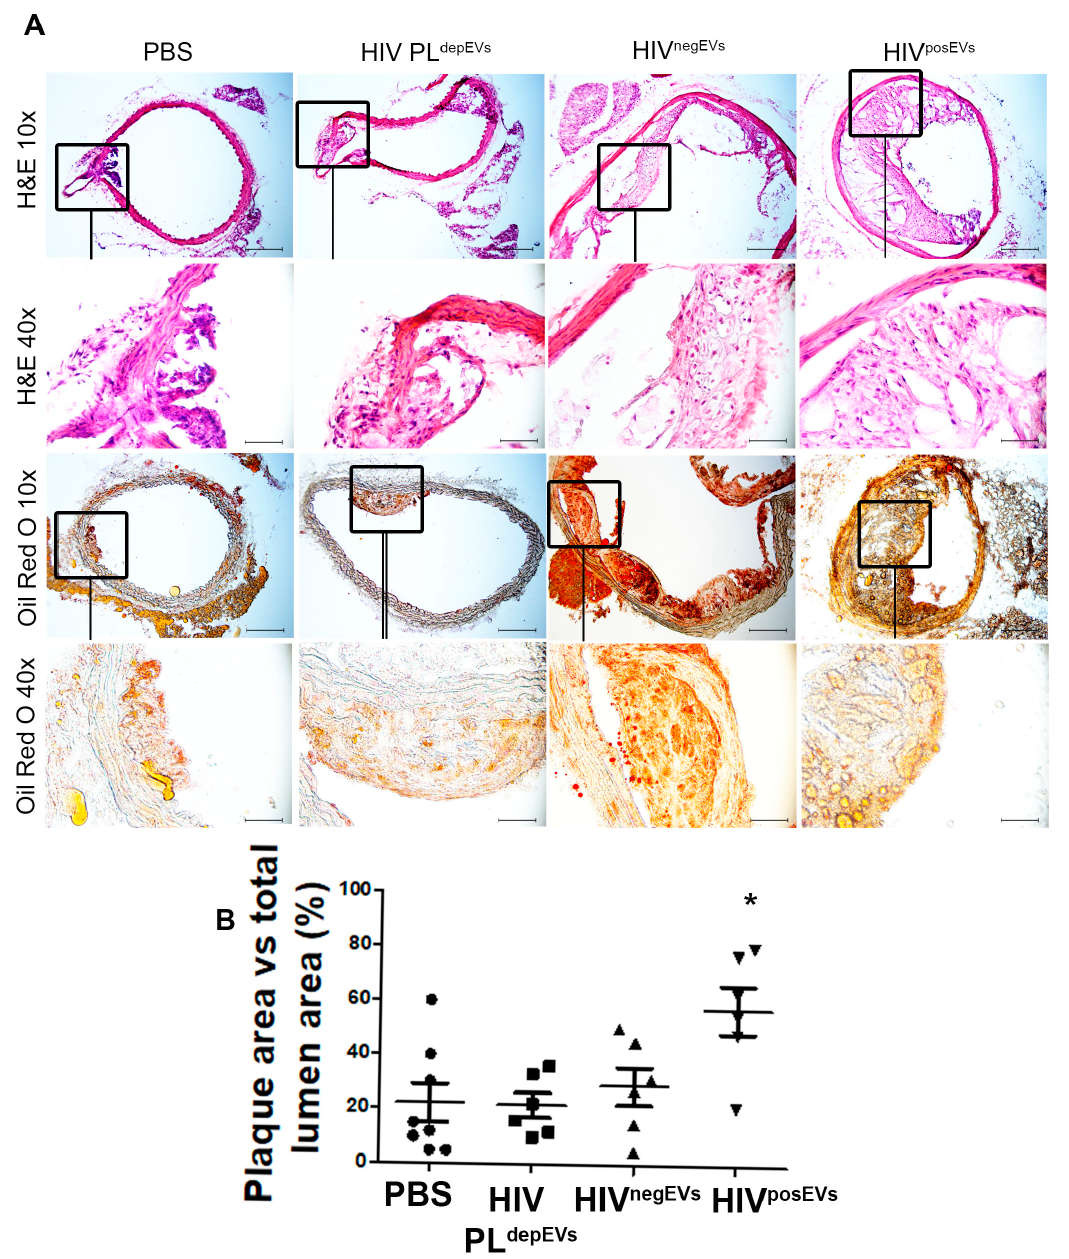
Figure 2. HIV posEVs increase atherosclerosis burden in apoE − / − mice. ( A ). Representative images of H&E and Oil Red O staining of aortic sections from mice treated with HIV posEVs , HIV PL depEVs , HIV negEVs or PBS. Mice treated with HIV posEVs have the most severe atherosclerotic lesions. ( B ). The ratio of plaque area/total lumen area in the four treatment groups (* p < 0.05). N = 5 animals per group. Statistical tests used: Kruskal–Wallis and Dunn’s Multiple Comparison Test as a post test. Scale bars: 10 × , 200 µ m; 40 × , 50 µ